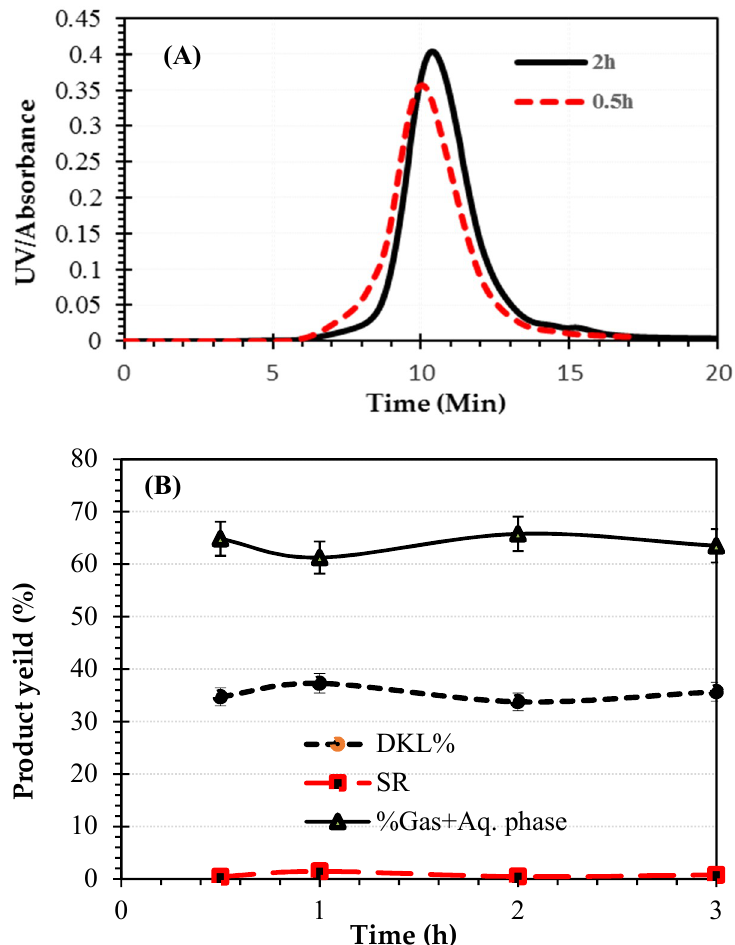
Figure 3. Effects of reaction time on M W of DKLs ( A ) and reaction yields; ( B ) after treatment of black liquor from 0.5 to 3 h at 250 ◦ C.